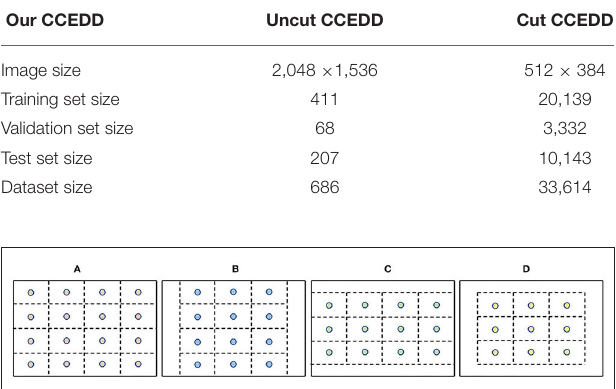
FIGURE 5 | Image cutting method. (A) 4 right; (C) move the grid down; (D) move the grid right and down.